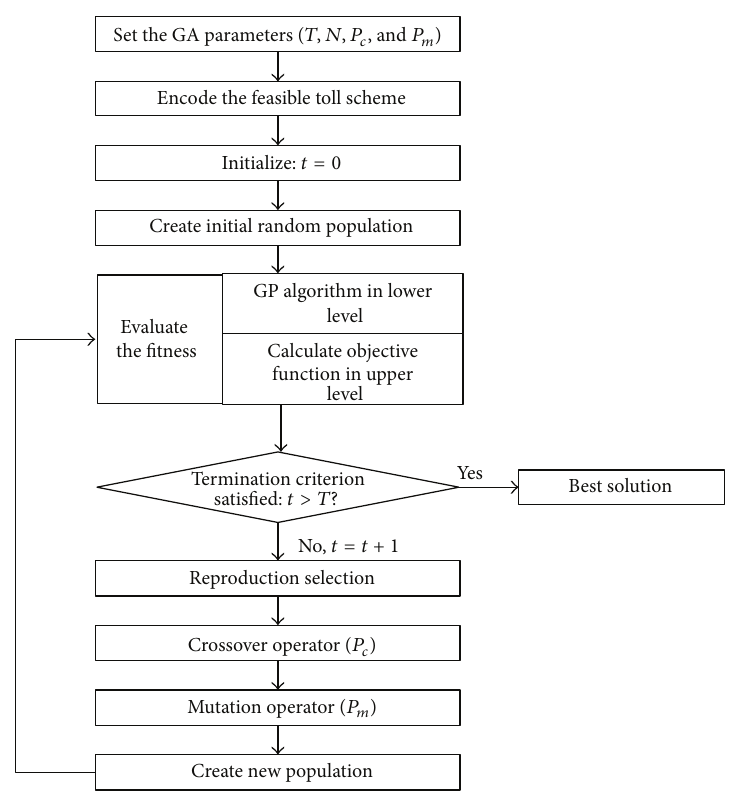
Figure 1: The implementation procedure of genetic algorithm.